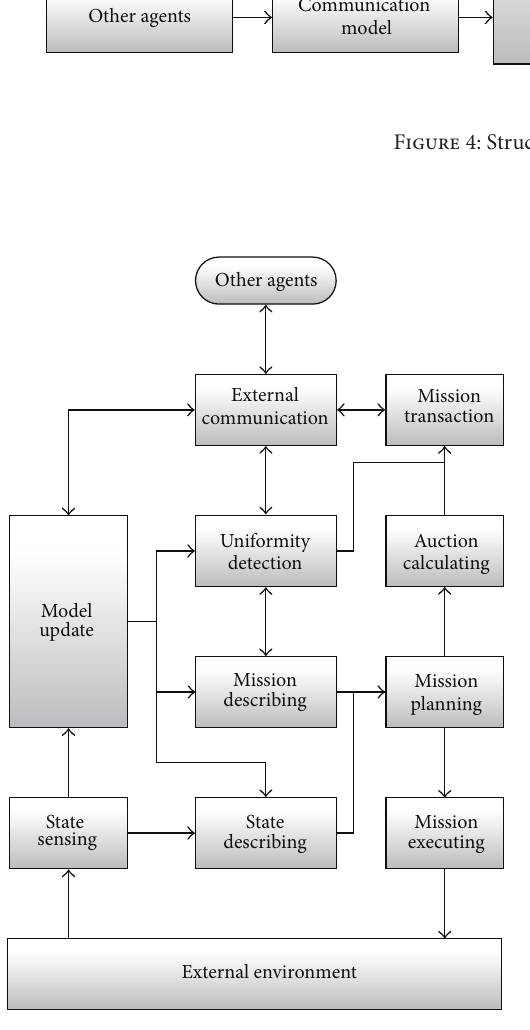
Figure 5: Float of the mission system.